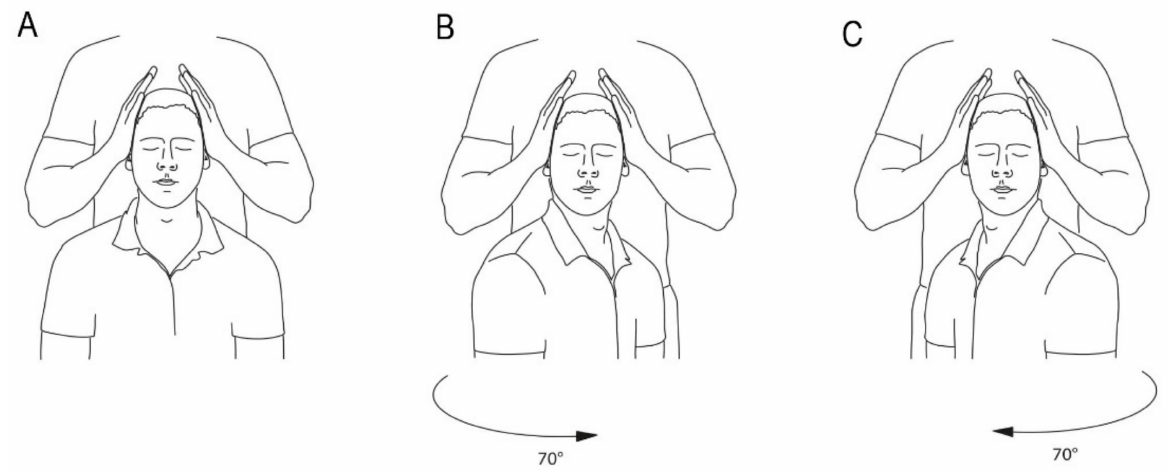
Figure 2. Cervical torsion test. ( A ) Subject seated in a rigid but fully rotatable chair, head fixed. ( B ) The subject ´ s trunk passively turned 70 degrees to the right, with the head still, then returned to centre. ( C ) Turning the trunk 70 degrees to the left, then returned to